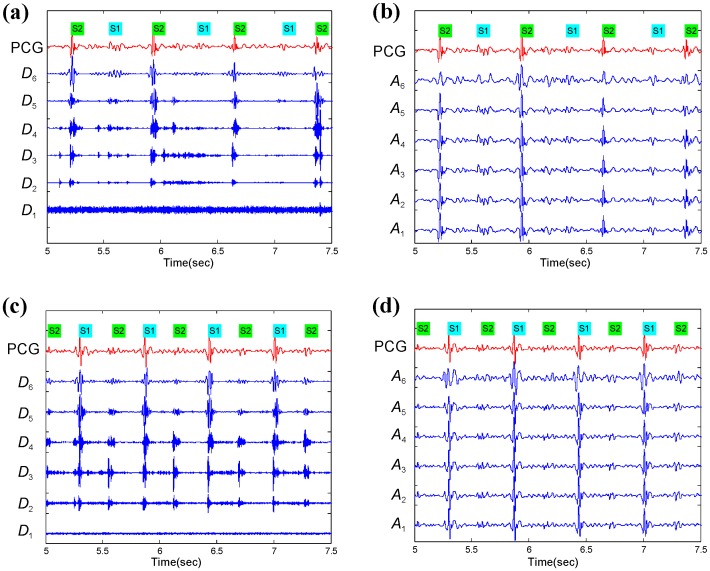
Behavior of the ‘db6’ wavelet dealing with different morphologies of S1 and S2.(a) Wavelet details for heart sounds with low S1 amplitude measured at the second intercostal space for a subject with mean PAp < 25 mmHg, (b) Wavelet approximations for the same heart sounds used in (a), (c) Wavelet details for heart sounds with low S2 amplitude measured at apex for a subject with mean PAp ≥ 25 mmHg, and (d) Wavelet approximations for the same heart sounds used in (c).